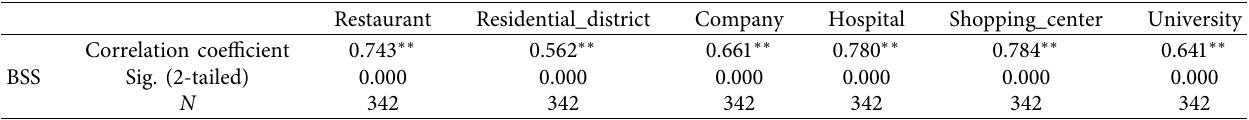
Table 5: Spearman’s rank correlation coefcient.